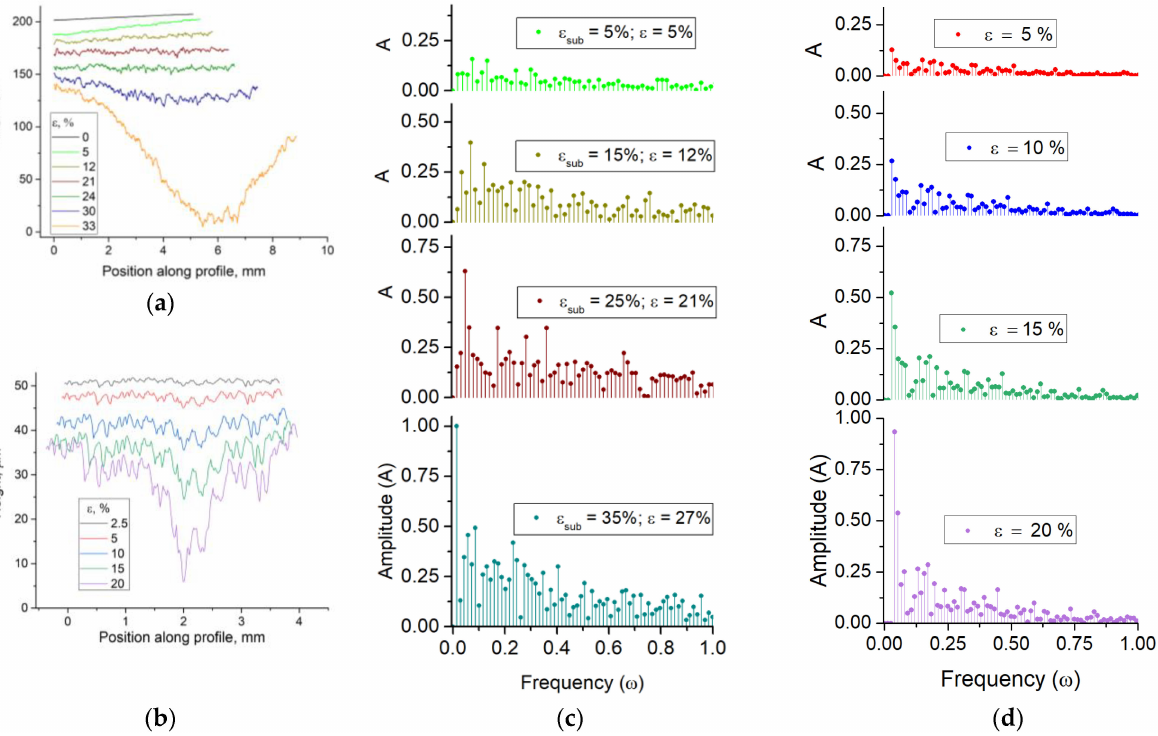
Figure 8. Surface profiles ( a , b ) and corresponding FFT spectra ( c , d ) obtained experimentally ( a , c ) and numerically ( b , d